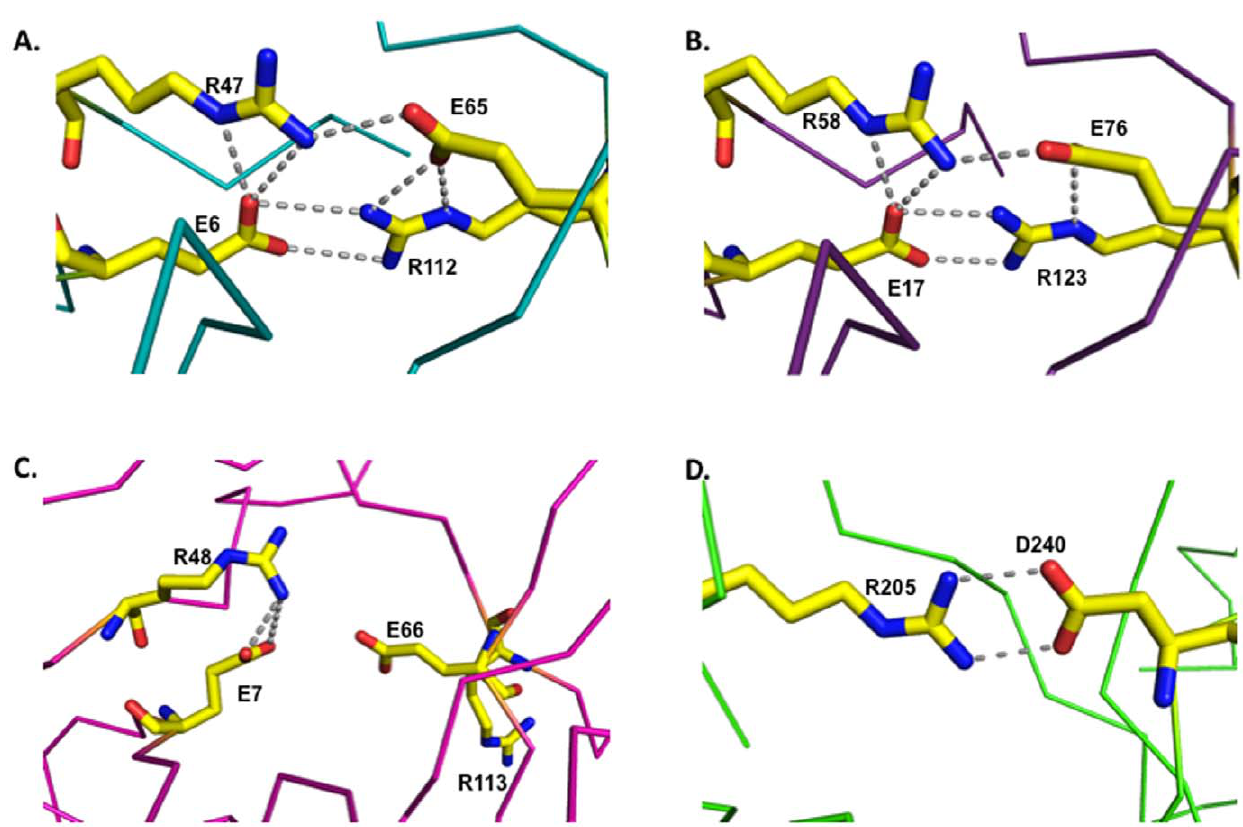
Figure 3. An interdomain ionic lock stabilizes the tandem Tudor architecture. The FXR1 (A) and FXR2 (B) domains are stabilized by extensive interactions between the charged residues at this interface. While the residues are conserved in the FMRP protein (C), the NMR structure suggested a slightly different domain orientation that results in a loss of salt bridging. (D) The UHRF1 interface is also stabilized by the formation of a salt bridge. The ribbon traces are colored to correspond with Figure 1 and residues comprising the ionic lock are colored in yellow for all panels.